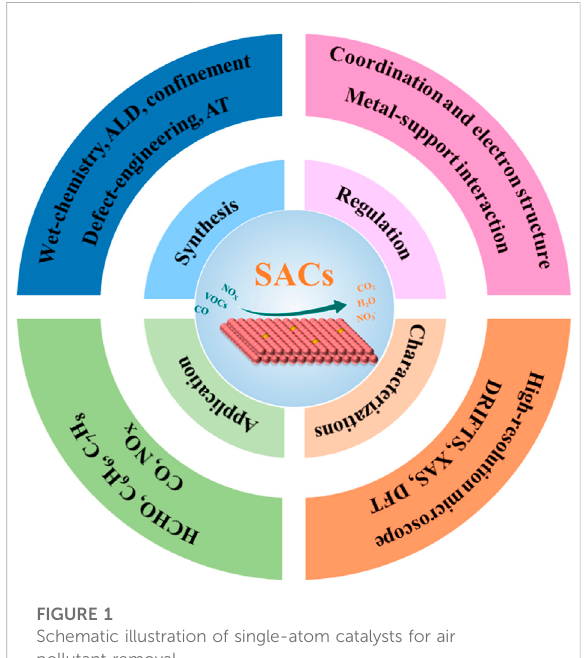
FIGURE 1 Schematic illustration of single-atom catalysts for air pollutant